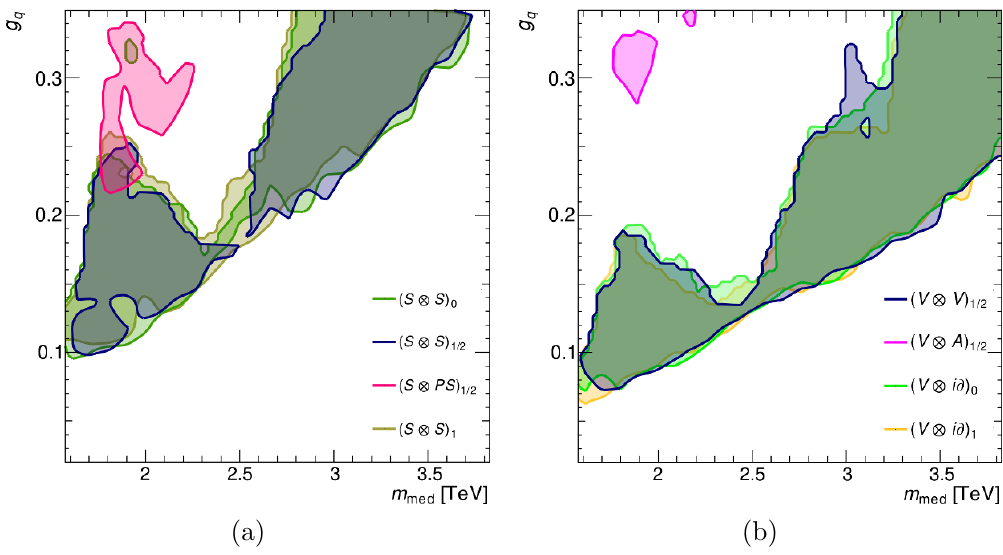
Figure 2 . Regions in the ( m med ; g q ) plane where a narrow resonance could be discovered with Z (cid:21) 5 (cid:27) C.L. in dijet (cid:12)nal states at the HL-LHC that are at the same time compatible with the detection of 150 signal events at XENONnT. The lower boundary of the region for each model is the smallest coupling g q ( m med ) for which we would expect a 5 (cid:27) discovery at the HL-LHC, while the upper boundary is given by the current 95 % C.L. exclusion limits from 36 fb (cid:0) 1 of CMS data. The left panel (a) corresponds to simpli(cid:12)ed models with a scalar mediator, while the right panel (b) refers to models with a vector